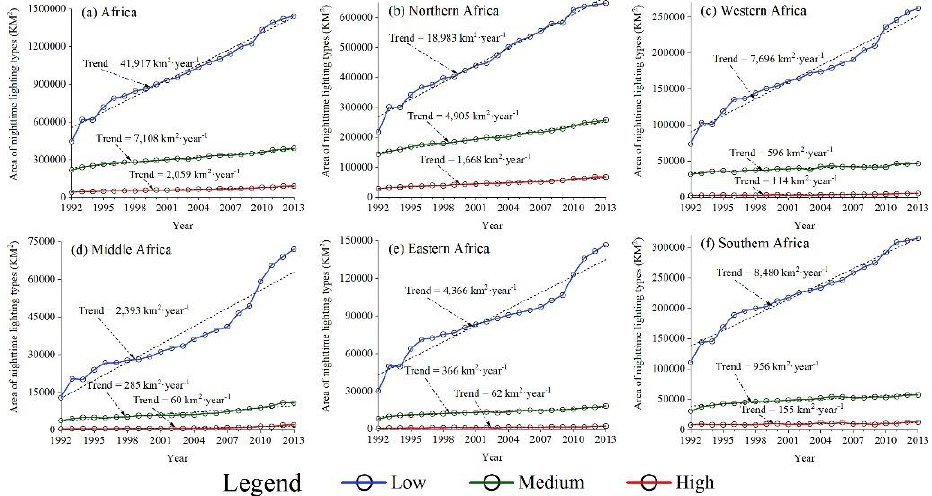
Figure 6. Long-term trends of different nighttime lighting types from 1992 to 2013: ( a ) Africa; ( b ) Northern Africa; ( c ) Western Africa; ( d ) Middle Africa; ( e ) Eastern Africa; ( f ) Southern Africa.